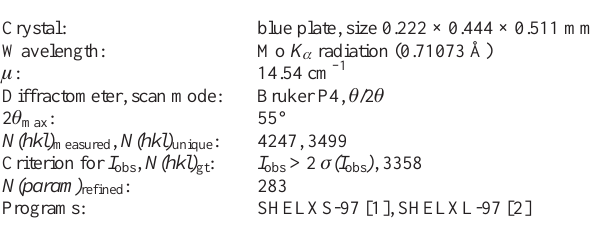
Table 1. Data collection and handling.